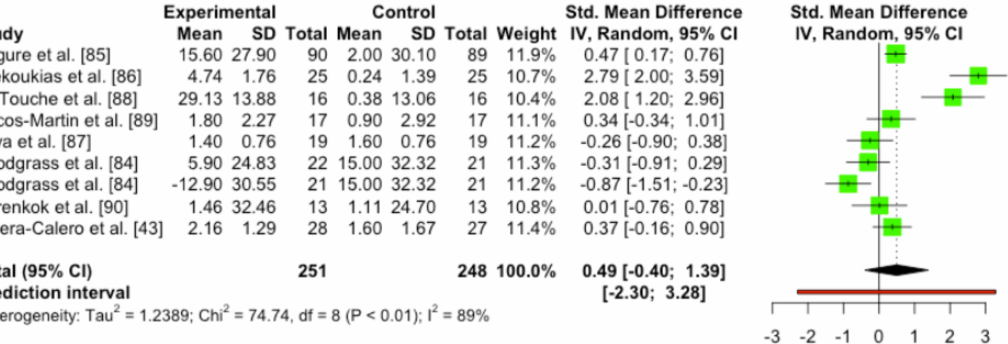
Figure 6. Meta-analysis of mobilization trials. Positive values = In favor of intervention/Negative values = In favor of sham intervention. Standard Deviation (SD); Standard (std); Inverse Variance (IV); Confidence Interval